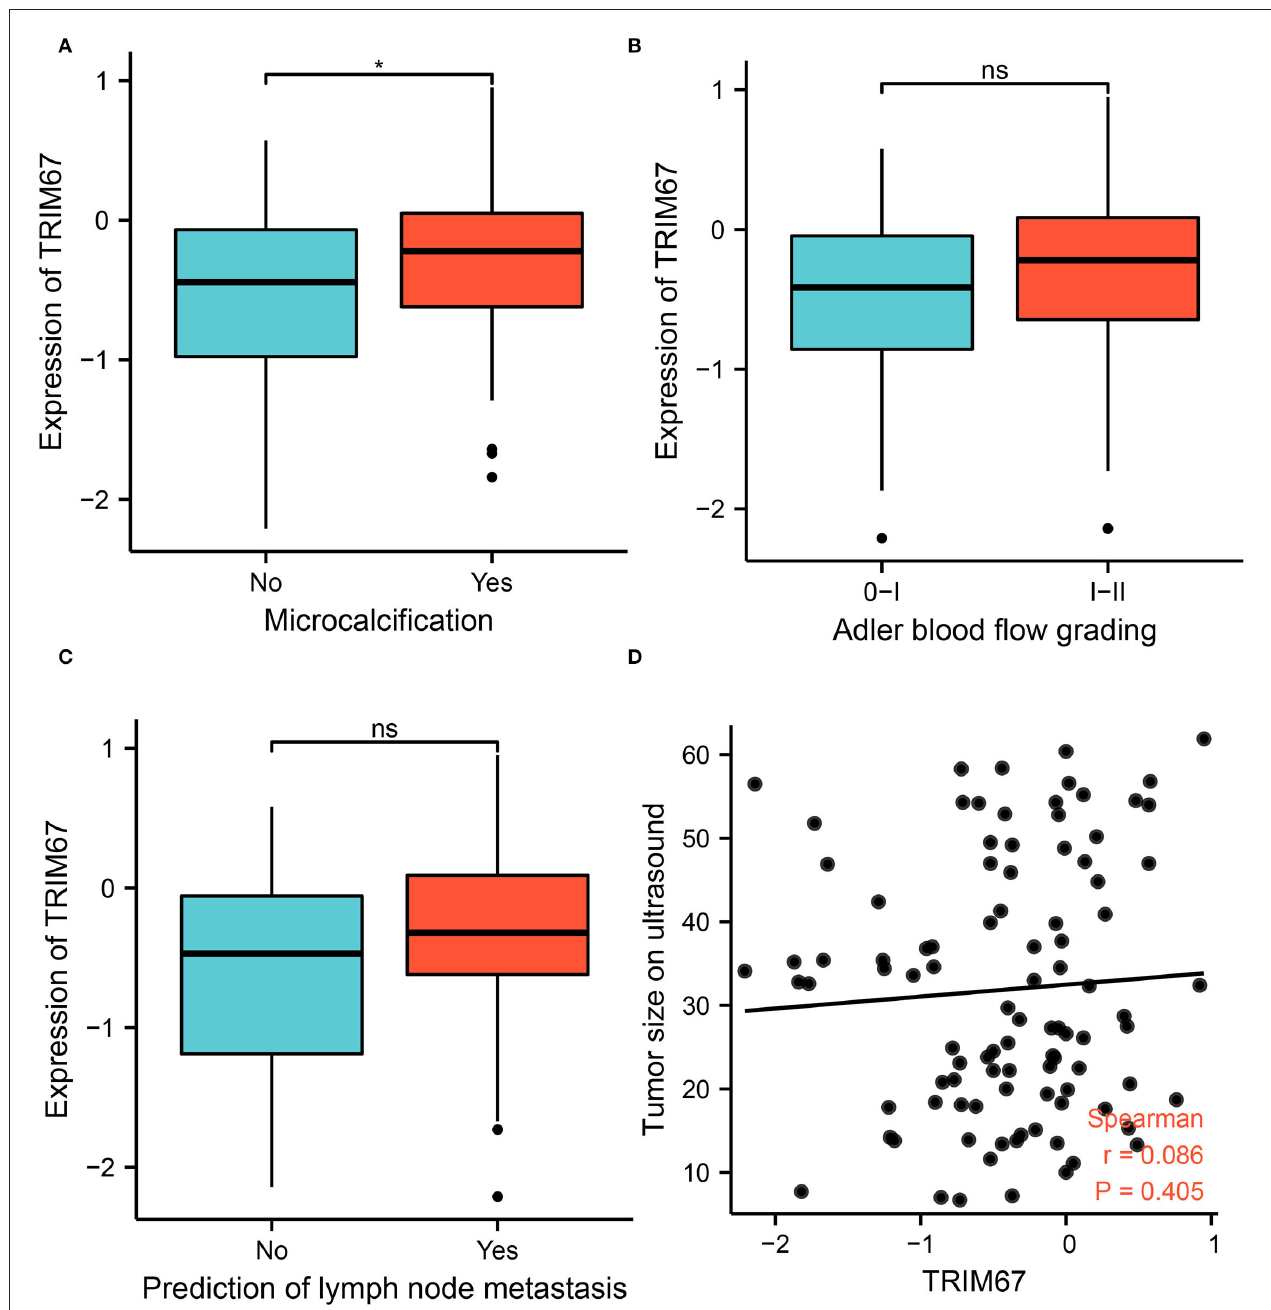
FIGURE 2 | Relationship between US-related features and TRIM67 expression. (A) Microcalcifications in tumor tissue correlated with TRIM67 expression ( p = 0.027); (B,C) The bar graph shows the relationship between Adler blood flow grading and lymph node metastasis in relation to differential expression of TRIM67 ; (D) Correlation analysis of tumor size on US and TRIM67